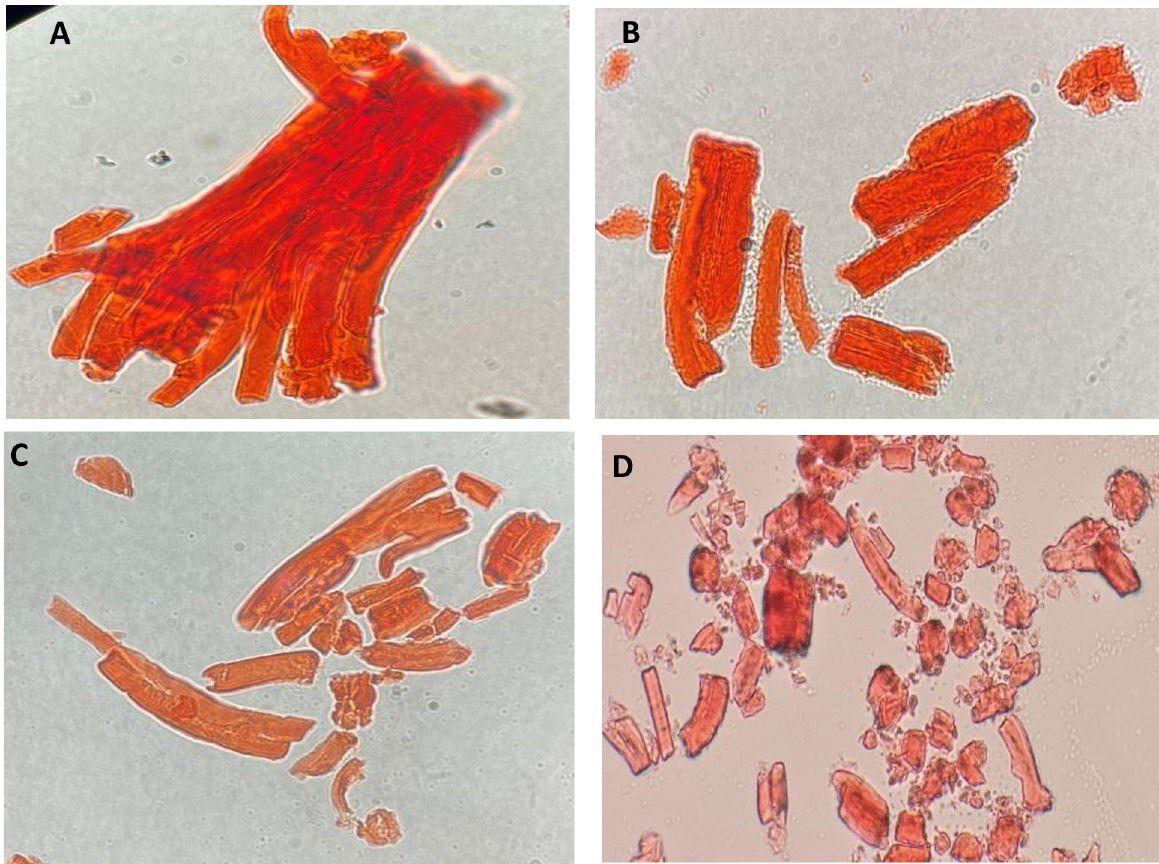
Fig 6. Elastin fibers degradation by gasm32 elastase under a 100x L.M lens. (Panel A: control treatment, Panel B: enzyme treatment for 1 hour, Panel C: enzyme treatment for 2 hours, and Panel D: enzyme treatment for 3 hours).